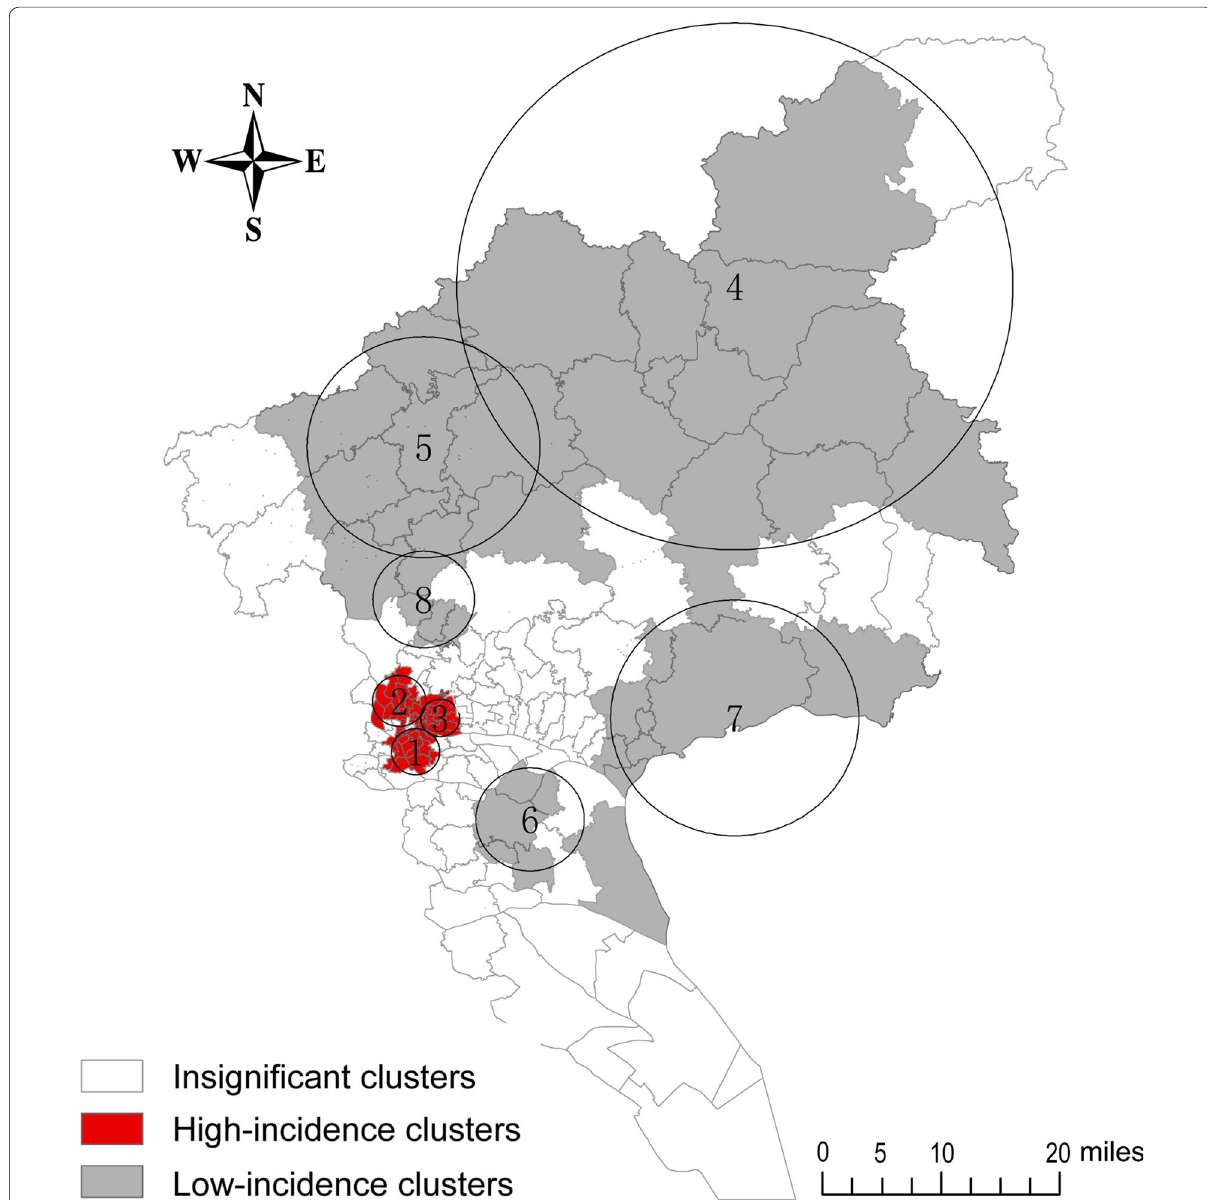
Fig. 3 Spatio‑temporal cluster map of colorectal cancer incidence in Guangzhou, China during 2010–2014. High 1–3 clusters: in the central urban areas, with significant higher incidences than those of other areas. Low 4–8 clusters: mainly in the surrounding suburban areas, with significant lower incidences than those of other areas. Insignificant clusters: the rest areas with dispersed